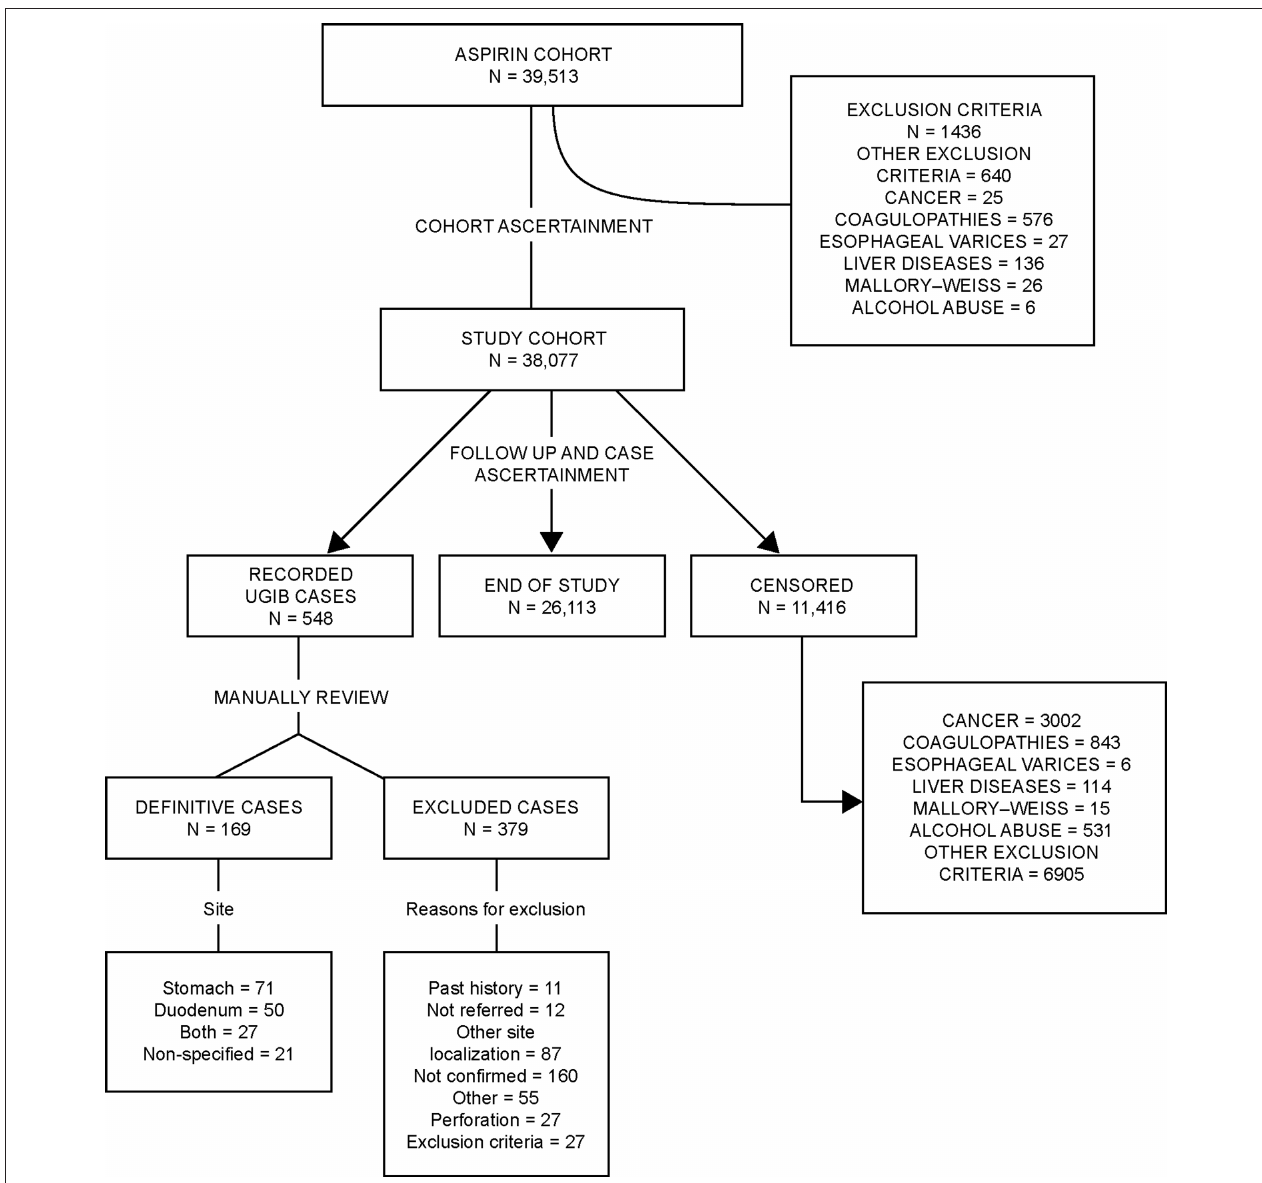
Figure 1 | Study design and case ascertainment. UGIB, upper gastrointestinal